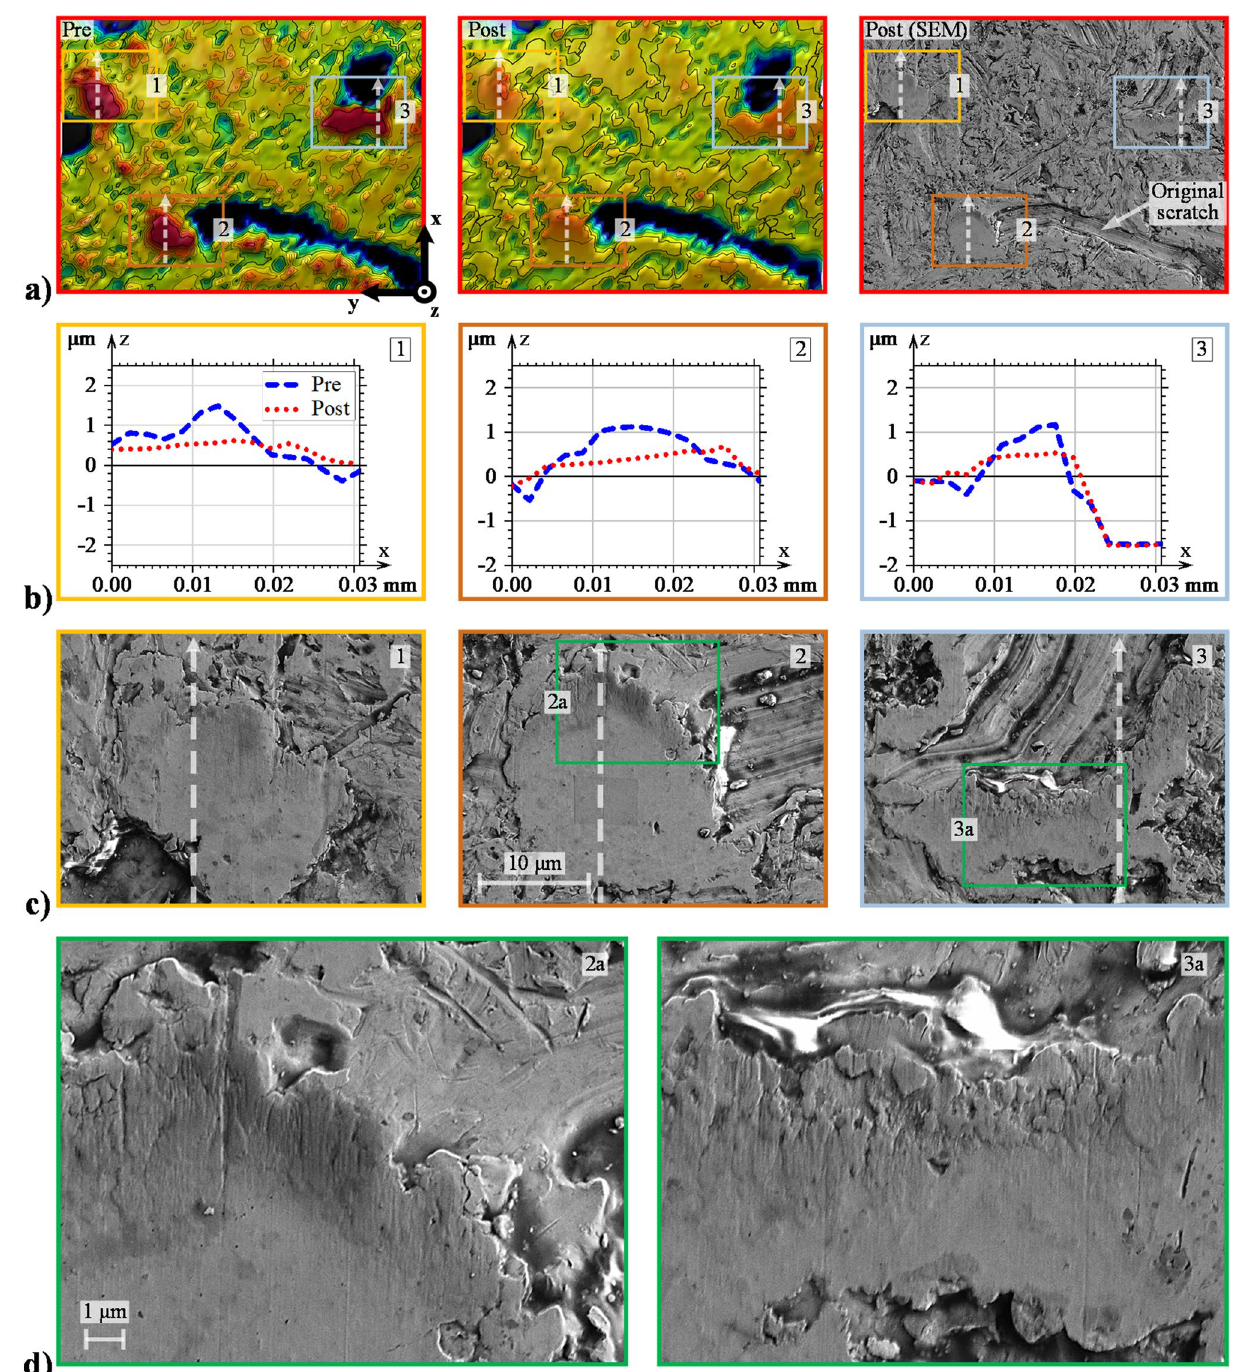
Figure 5. Detailed evaluation of the SRR-derived asperities: ( a ) enlarged view of area III in Fig. 2, ( b ) 2D profiles of prominent asperities taken in the direction of sliding, and ( c ) SEM analysis of the corresponding